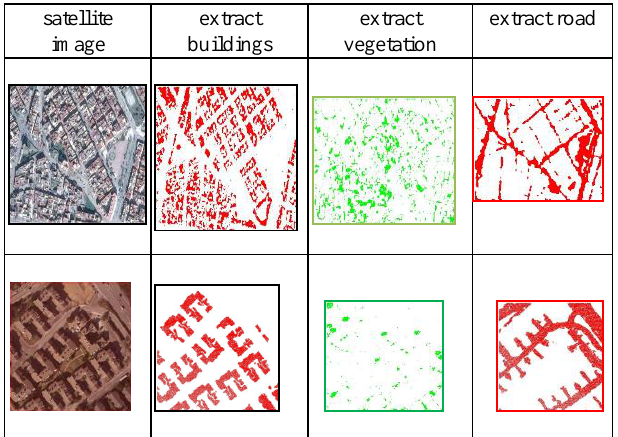
Figure 9: Visualization of satellite image, building class, vegetation class and road class.